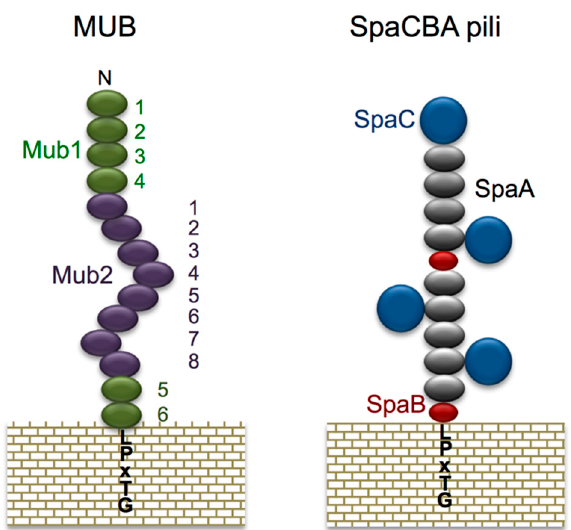
Figure 5. Schematic model of MUB and SpaCBA pili. MUB comprises 6 Mub1 repeats (green) and 8 Mub2 repeats (purple). The C-terminal LPXTG motif anchors MUB to the peptidoglycan of the bacterial cell wall. Reproduced from Roos and Jonsson [68] and Etzold et al. [70] with several modifications. The heterotrimeric SpaCBA pili are composed of shaft-forming SpaA (gray) major pilins together with SpaB (red) and SpaC (navy) minor pilins. Reproduced from Kankainen et al. [76] and Reunanen et al. [77] with several modifications.